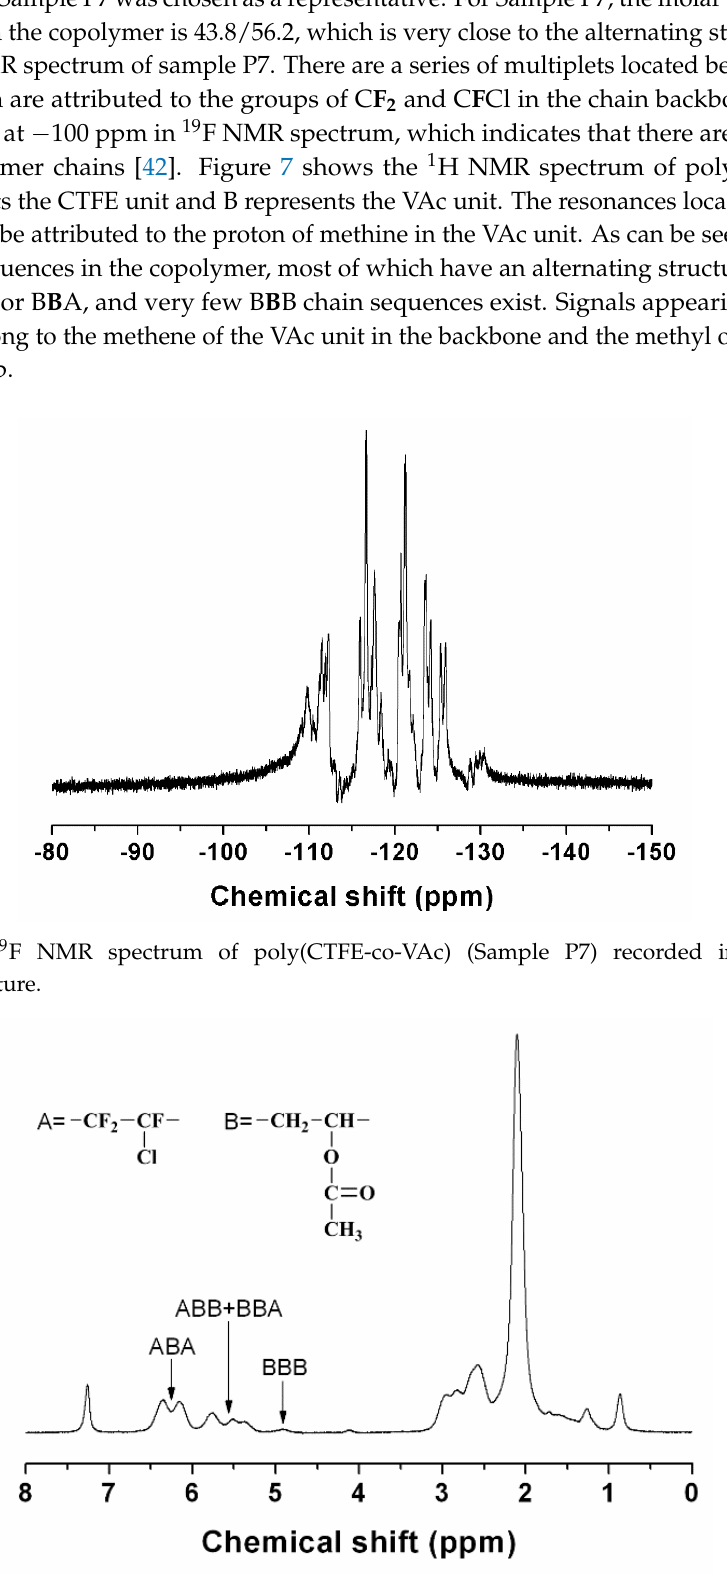
Figure 7. 1 H NMR spectrum of poly(CTFE-co-VAc) (Sample P7) recorded in CDCl 3 at room temperature.